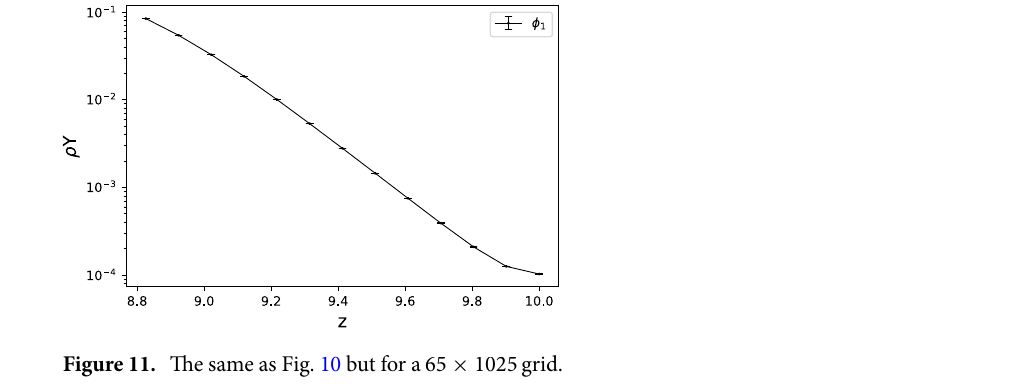
Figure 11. The same as Fig. 10 but for a 65